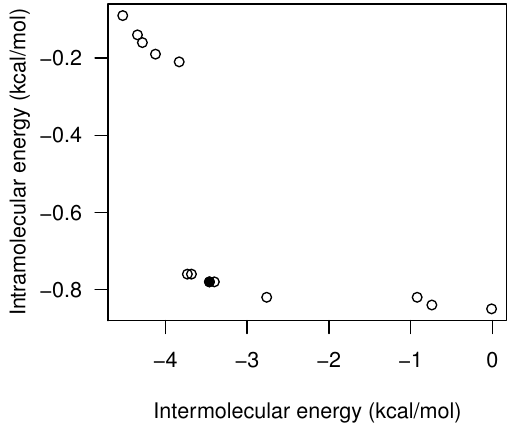
Figure 10. The plot represents all sets of solutions obtained from the SMPSO algorithm from Run 5. The black point corresponds to the solution selected. The final binding energy of the conformation selected equals -2.27 kcal/mol. The E and − 0.78 kcal/mol, respectively.